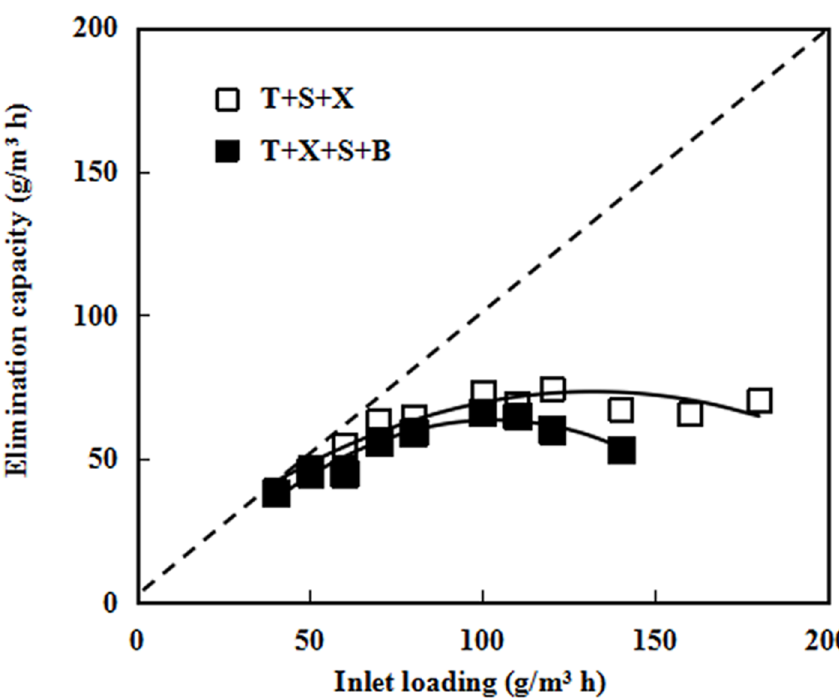
Fig 4. Elimination capacities of ternary (TXS) and quaternary (BTXS) mixture with inlet loadings. B: benzene; T: toluene; X: xylene; S: styrene.